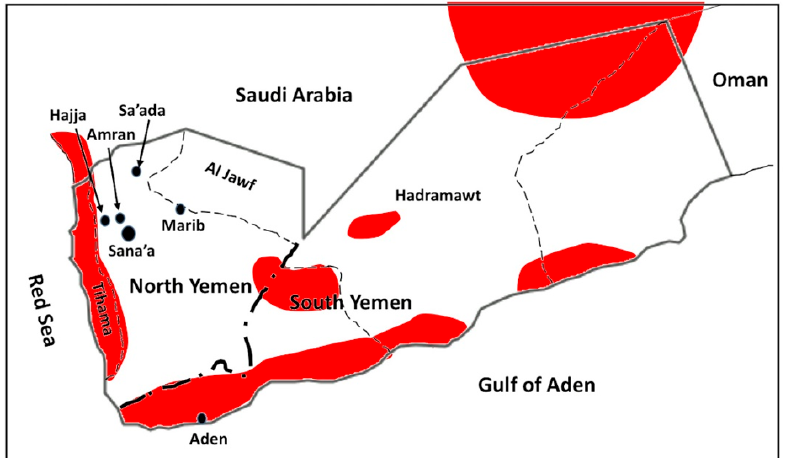
Figure 15. Locations and regions mentioned in the text in relation to desert locust activity and inScheme 1990. when traditionalist North Yemen and Marxist South Yemen (Figure 15) merged after years of skirmishing [98,99]. In mid-1994, a civil war erupted for several weeks, ending in defeat for separatist southern Yemen [99,100]. The war damaged infrastructure [100] and ministries were looted, including the ministry of agriculture, weakening Yemen’s anti-locust capability [8]. North versus south enmity persisted [100,101] through